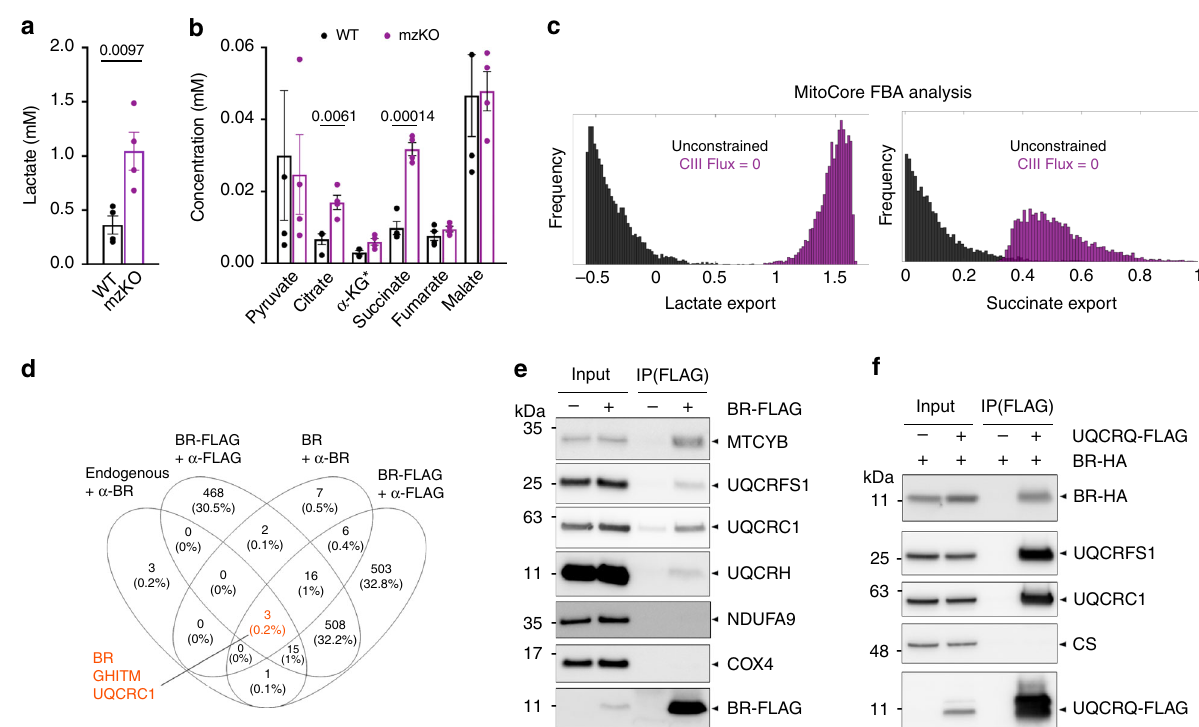
Fig. 5 Br functionally and physically interacts with electron transport chain complex III. a Lactate concentrations in 5 dpf WT and mzKO larvae. Data represent mean and SEM of four independent clutches each with 50 larvae per genotype. p -values from two-sided paired t -test. b Citric acid cycle organic acid concentrations in 5 dpf WT and mzKO larvae. Data represent mean and SEM of four independent clutches each with 50 larvae per genotype. p -values from two-sided paired t -test with Bonferroni correction. * α -KG concentrations are a 10-fold multiple to enable visualization on the same scale. c Distributions of the export rate of lactate and succinate (5000 fl ux samples) comparing the unconstrained MitoCore model versus the CIII-blocked model derived by MitoCore fl ux balance analysis (FBA). d Venn diagram depicting intersections of proteins identi fi ed in 4 co-IP/mass spec experiments of BR in HEK293T mitochondria. Endogenous BR and overexpressed untagged BR were immunoprecipitated with α -BR, overexpressed BR-FLAG with α -FLAG. e Immunoprecipitation of BR-FLAG followed by immunoblotting for indicated ETC proteins from mouse mitochondria with AAV9-mediated expression of BR-FLAG. MTCYB, UQCRFS1, UQCRC1, and UQCRH are components of CIII. NDUFA9 and COX4 are components of CI and CIV, respectively. f . Reciprocal IP of BR with CIII components. UQCRQ-FLAG and BR-HA were co-transfected into HEK293T. UQCRQ-FLAG immunoprecipitation was followed by immunoblotting for BR-HA and indicated proteins. CS is an unrelated matrix